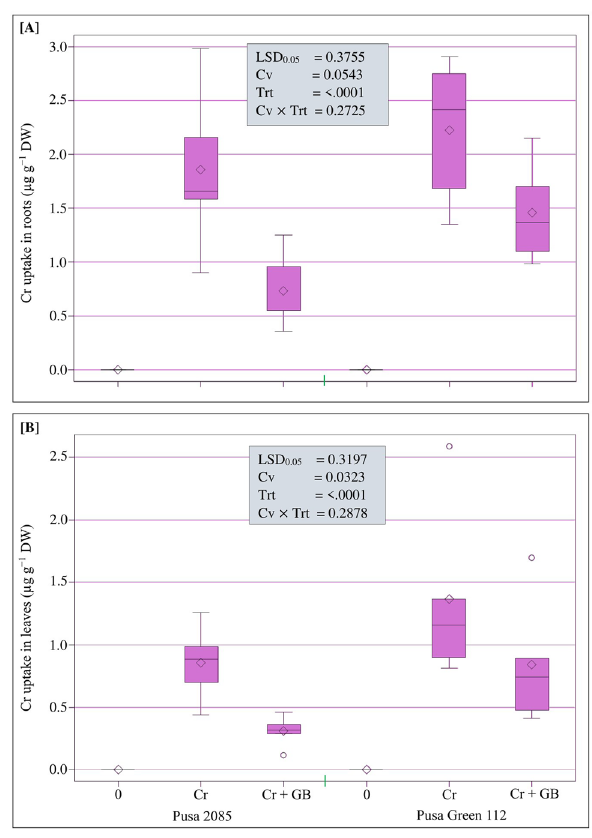
Figure 7. Box plot distribution of total Cr uptake (µg g −1 DW) in roots and leaves of both chickpea cultivars (Pusa 2085 and Pusa Green 112) grown in the presence of 0 and 120 µM Cr and 120 µM Cr + 100 mM glycine betaine (GB) at 42 days after sowing (grown in pots). Least significant differences (LSD 0.05 ) were calculated for all the treatments using SAS 9.4